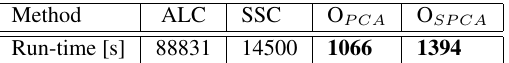
Table 4: Computation-Time (s) on all the Hopkins 155 dataset. is one of the most accurate subspace-based algorithm. But due to the property of MSMC, which is based on computing the affini- ties between each pair trajectories, it is highly